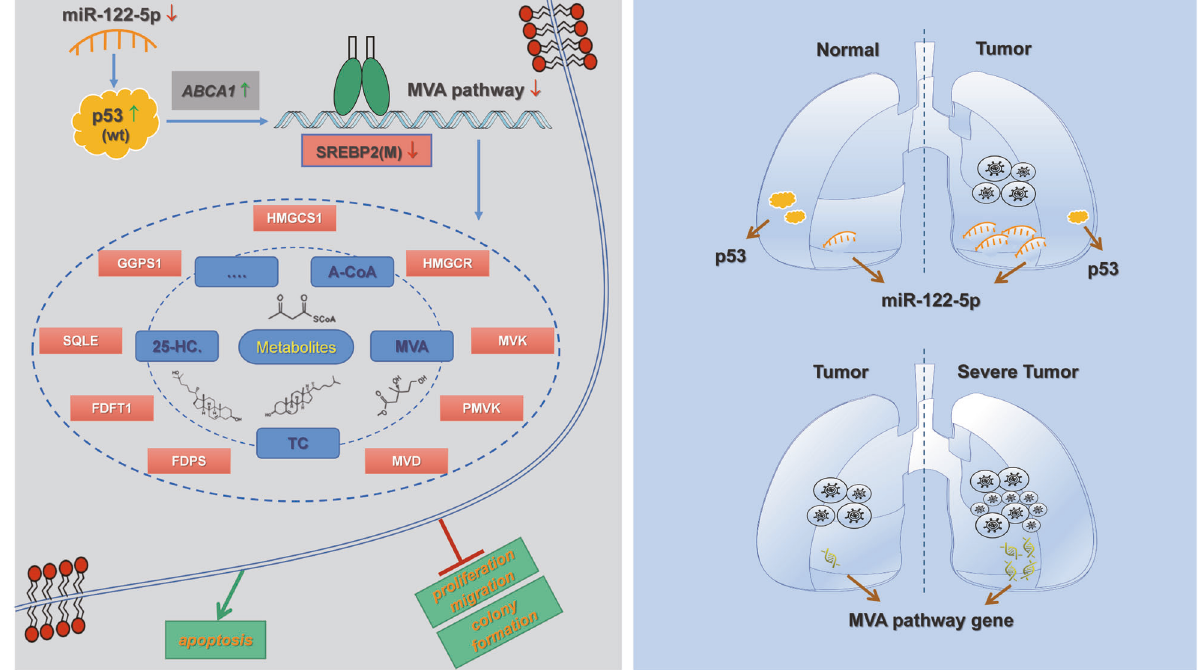
Fig. 7 Mechanism diagram of miR-122-5p regulates the mevalonate pathway by targeting p53 in non-small cell lung cancer. Inhibition of miR-122-5p in NSCLC cells A549 led to the up-regulation of p53 expression. This elevated the expression of the p53 target gene ABCA1, inhibited the maturation of SREBP2, hindered the MVA pathway, affected the proliferation and migration of A549 cells, and promoted apoptosis of A549 cells. MiR-122-5p was negatively correlated with p53 expression in NSCLC tumor tissues. The malignancy of NSCLC could be positively associated with the expression of key genes in the MVA pathway.